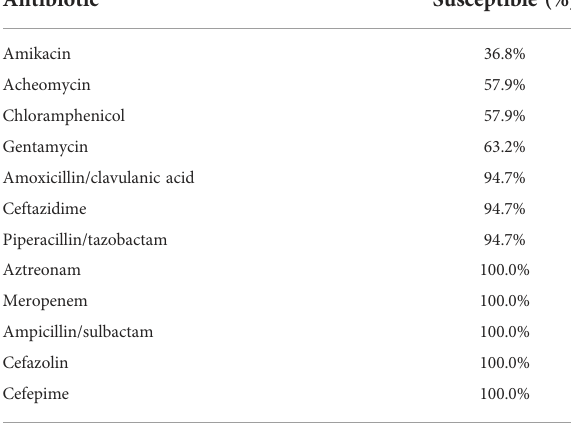
TABLE 4 Antimicrobial susceptibility of isolates from patients with carbapenem-resistant klebsiella pneumoniae infection.